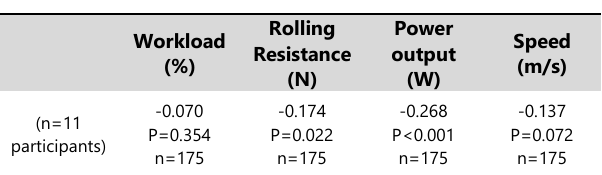
Table 4 . Spearman’s Rho Correlations Between Upper Arm ActiGraph-Video Push Count Difference and Workload, Rolling Resistance, Power Output, and